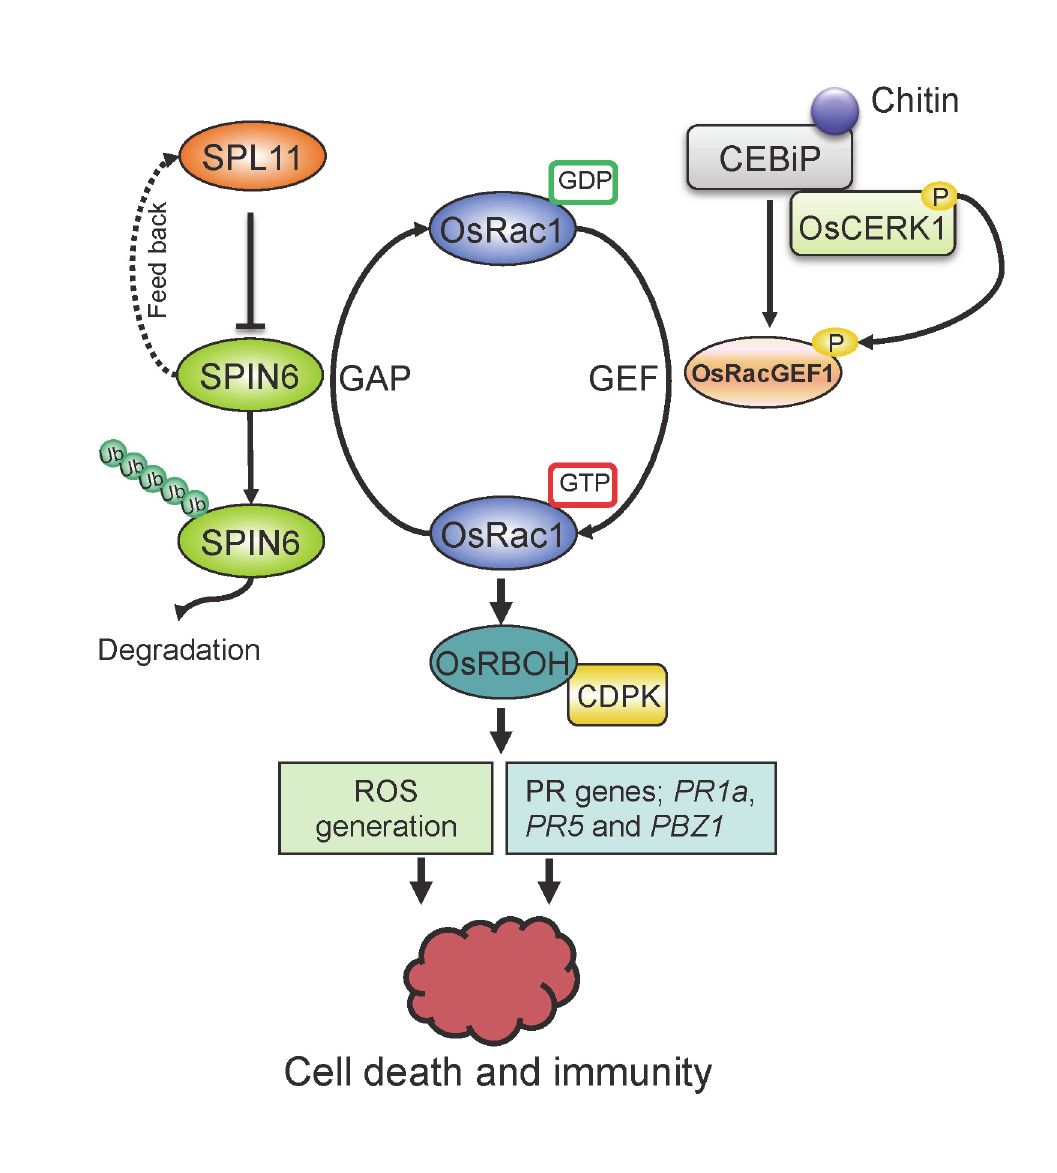
Figure 7. Proposed working model of the relationship between SPL11, SPIN6, and OsRac1. By associating with RhoGAP protein SPIN6, the E3 ligase SPL11 negatively modulates OsRac1-mediated immune signaling. SPIN6 is ubiquitinated and degraded by the E3 ligase SPL11 via the 26S proteasome system. From the GDP state to the GTP state, OsRac1 is activated by the GEF protein OsRacGEF1, then associates with the NADPH oxidases OsRBOH/ CDPK complex to trigger ROS generation. The activation of OsRac1 requires the phosphorylation by the kinase protein OsCERK1, a co-receptor of the PAMP effector chitin. OsCERK1 dimerizes with LysM protein CEBiP1 to perceive chitin signaling. The interaction between SPIN6 and OsRac1 may lead to the change of OsRac1 from the GTP state to the GDP state, which reduces the active form of OsRac1 in rice cells. Mutation in the Spin6 gene may cause accumulation of ROS and PR proteins, i.e., PR1a, PR5 and PBZ1, that results in plant cell death and immunity.